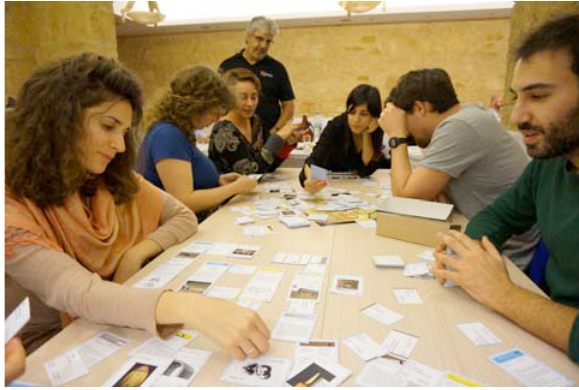
Figure 5. Teams playing the CIDOC CRM Game in a workshop In the first stage of the game, players are given game boards which have slots available for instance cards and class cards.